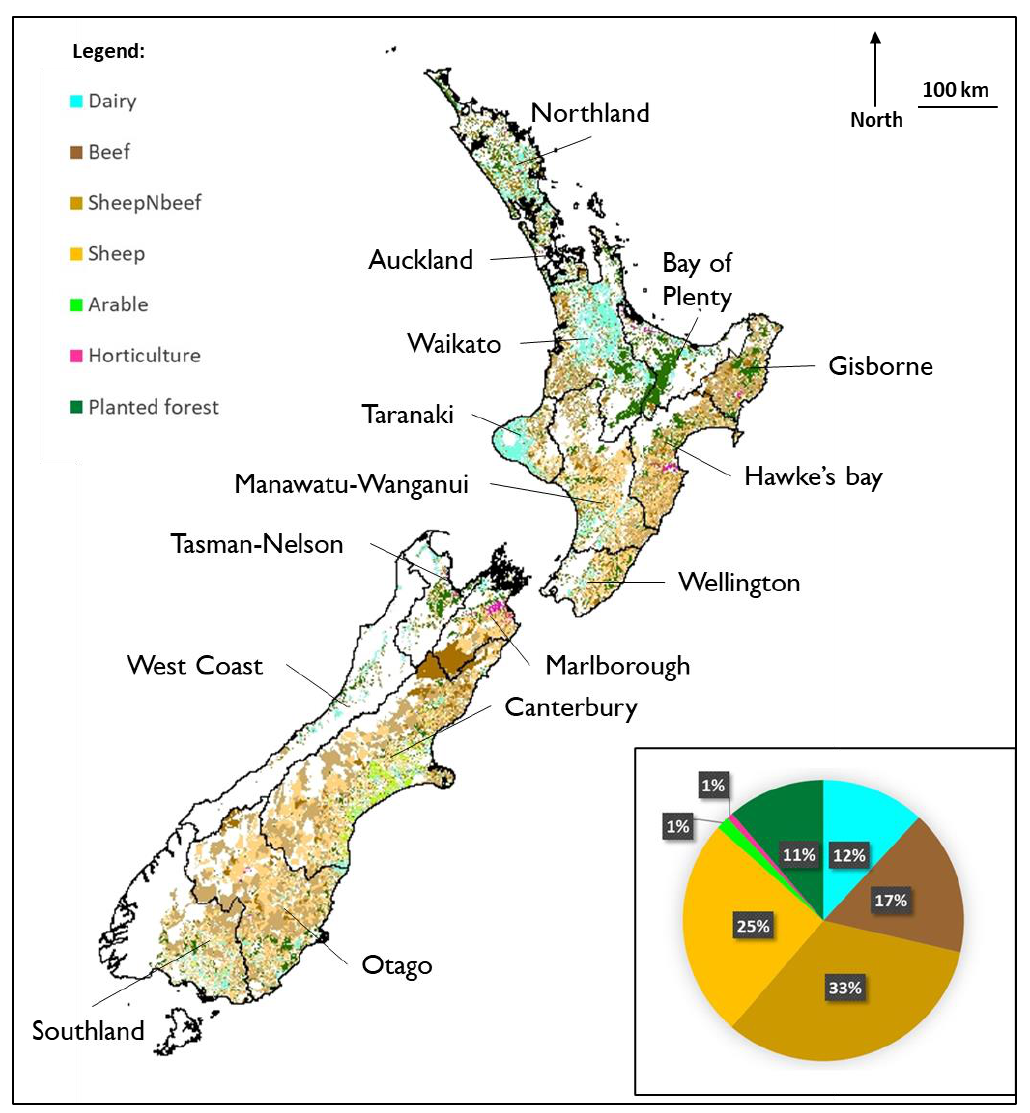
Figure 1. The agricultural land use in New Zealand. (Data sources: LUCAS NZ Land Use Map 1990 2008 2012 2016 v006, Ministry for the Environment; Land Use Capability, Manaaki Whenua Landcare Research; AgriBase, Asure Quality Kaitiaki Kai.).